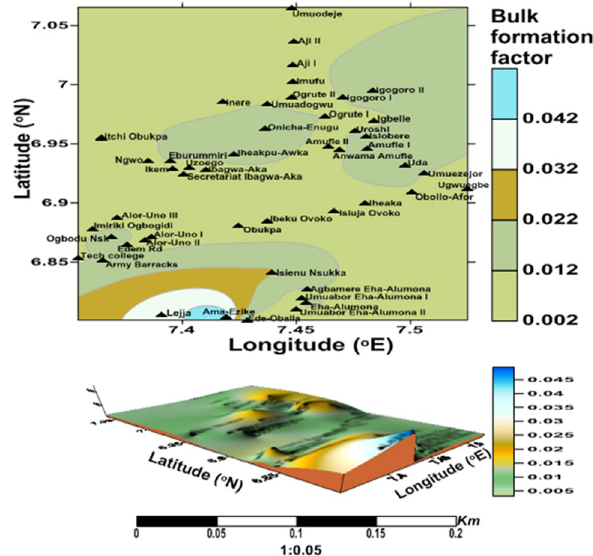
Fig. 10 2D and 3D contour map showing the variation of bulk forma- tion factor in the study